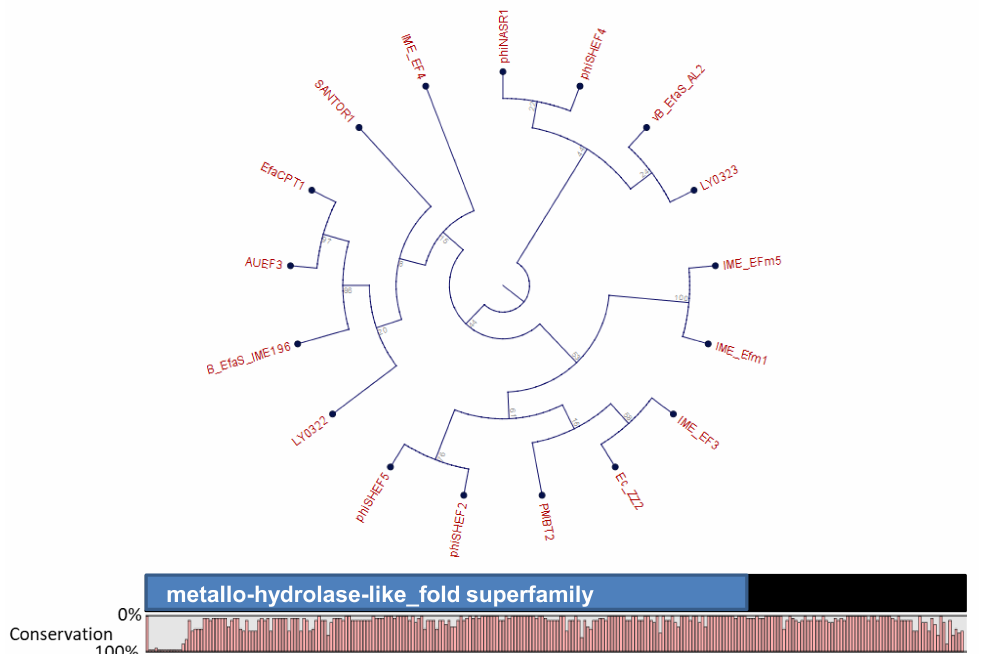
Figure 2. Maximum likelihood phylogenetic analysis sequence relatedness of the Enterococcus faecalis phage putative metallo-beta-lactamase gene (orthologous group 32); tree node labels represent bootstrap